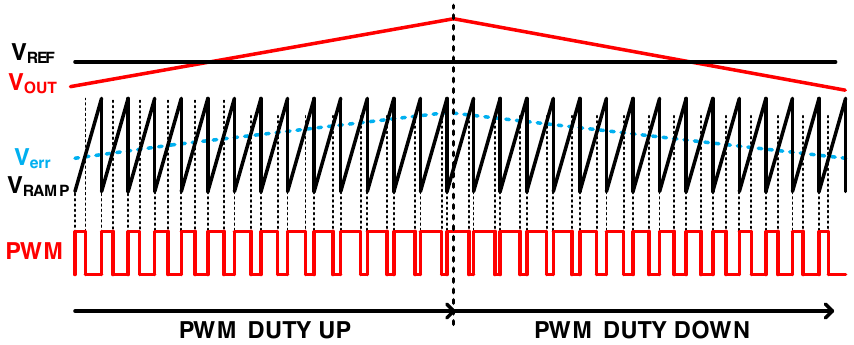
Figure 2. Structure of a DC–DC converter with the APWM.